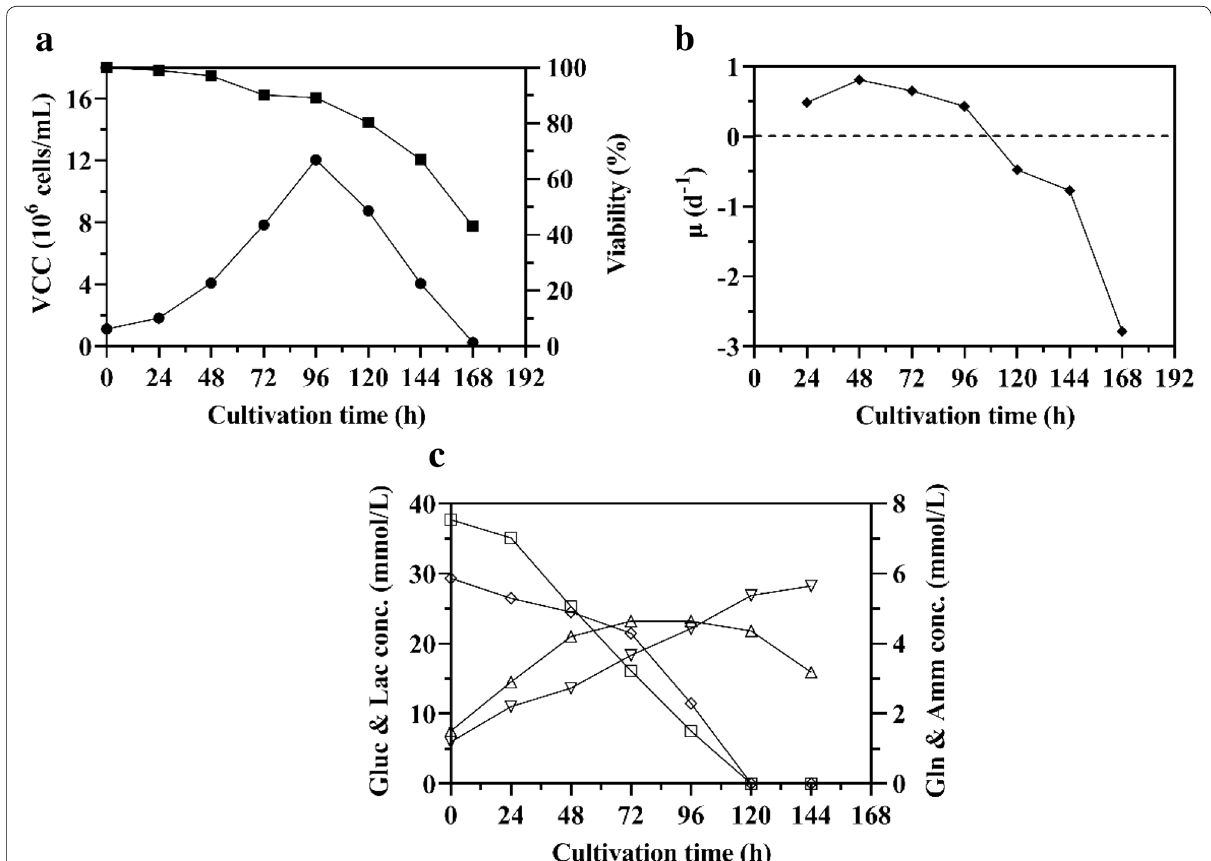
Fig. 2 Growth and metabolism of MDCK suspension cells in Xeno serum‑free medium in shake flasks ( n circle) and cell viability (black square) over the batch cultivation. b Cell‑specific growth rate (black diamond). c Concentrations of extracellular metabolites, including glucose (Gluc) (white square), glutamine (Gln) (white diamond), lactate (white triangle), and ammonium (Amm) (inverted white triangle), over the batch cultivation. The horizontal dashed line indicates the cell‑specific growth rate of 0 day −